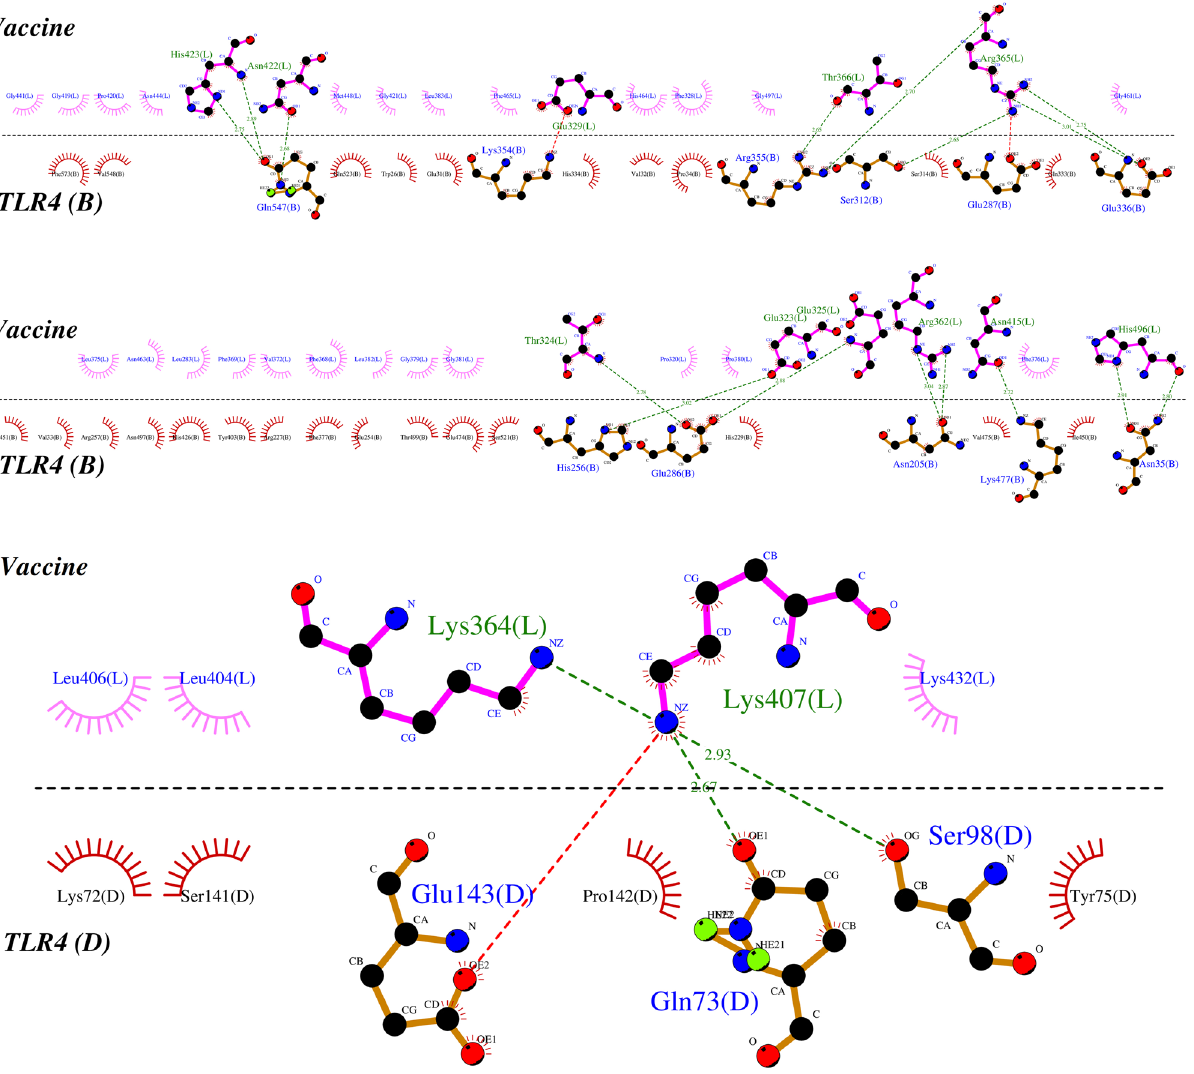
Figure 5. Interaction of the vaccine with chains B and D of TLR4 was visualized using the LigPlot software. The green dashed lines indicate hydrogen